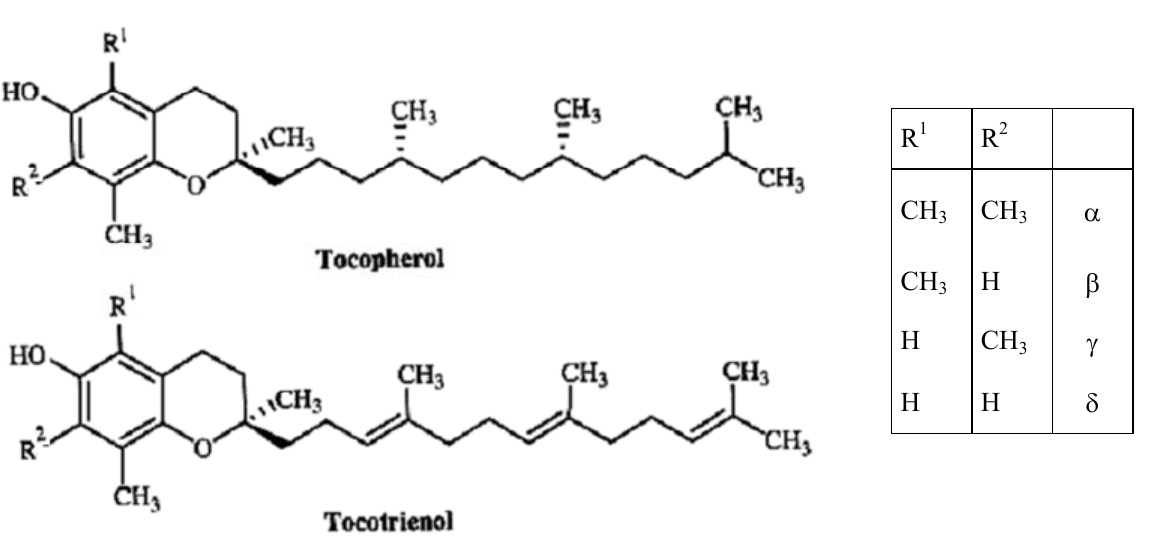
Figure 1. Tocopherol and tocotrienol